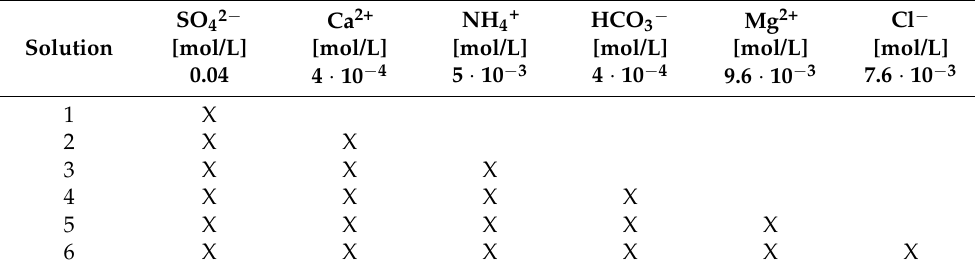
Table 1. Composition of synthetic solutions prepared for corrosion tests.